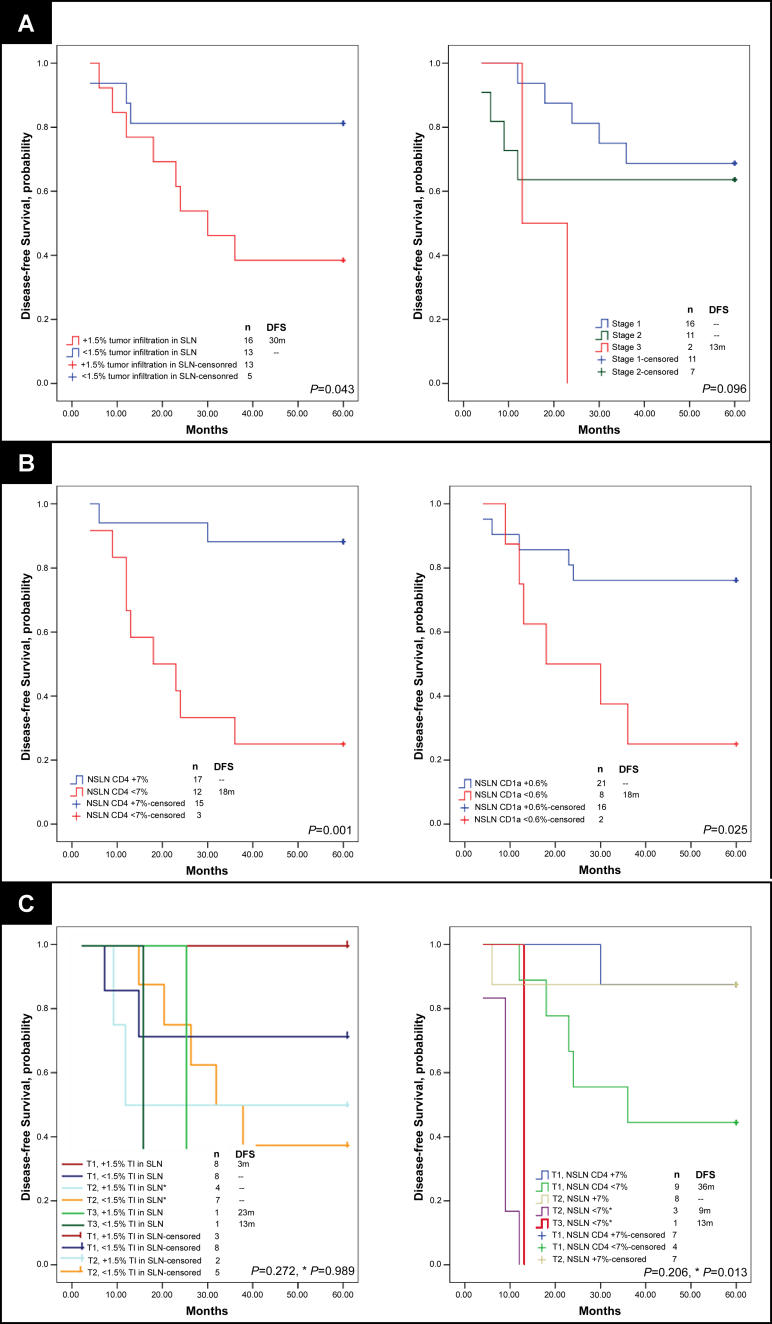
Disease-free Survival Analysis of Women with Breast Cancer According to Immune profile Characteristics, Learning Set ALN Series 2, and Test SetKM curves are shown for (A) median DFS applied to the learning set ALN series 2 (n = 27) and test set (n = 48) according to size of CD4 T cell and CD1a dendritic cell populations within learning set ALN series 2 (second, randomly selected ALN per individual); (B) DFS stratified by size of CD4 T cell and CD1a dendritic cell populations within test set ALNs; and (C) DFS applied to the learning set (n = 29) and test set (n = 48) according to size of ALN CD4 T cell and ALN CD1a dendritic cell populations. Thresholds for ALN CD4 T cell and ALN CD1a dendritic cell populations were determined by ROC curves as applied to the learning set (ALN series 1). Median duration of DFS are indicated; – indicates a median DFS greater than follow-up period, 5 y. Of 29 individuals in learning set ALN series 1, 11 had recurrent disease, and of 27 individuals in learning set ALN series 2, 11 had recurrent disease. Of 48 individuals in the test set of ALNs, 22 had recurrent disease. For ALN selection from the learning set (C), a single ALN was randomly selected from series 1 or series 2 per individual. Adjusted p-values were determined by the permuted log-rank statistic for comparison of DFS between groups.